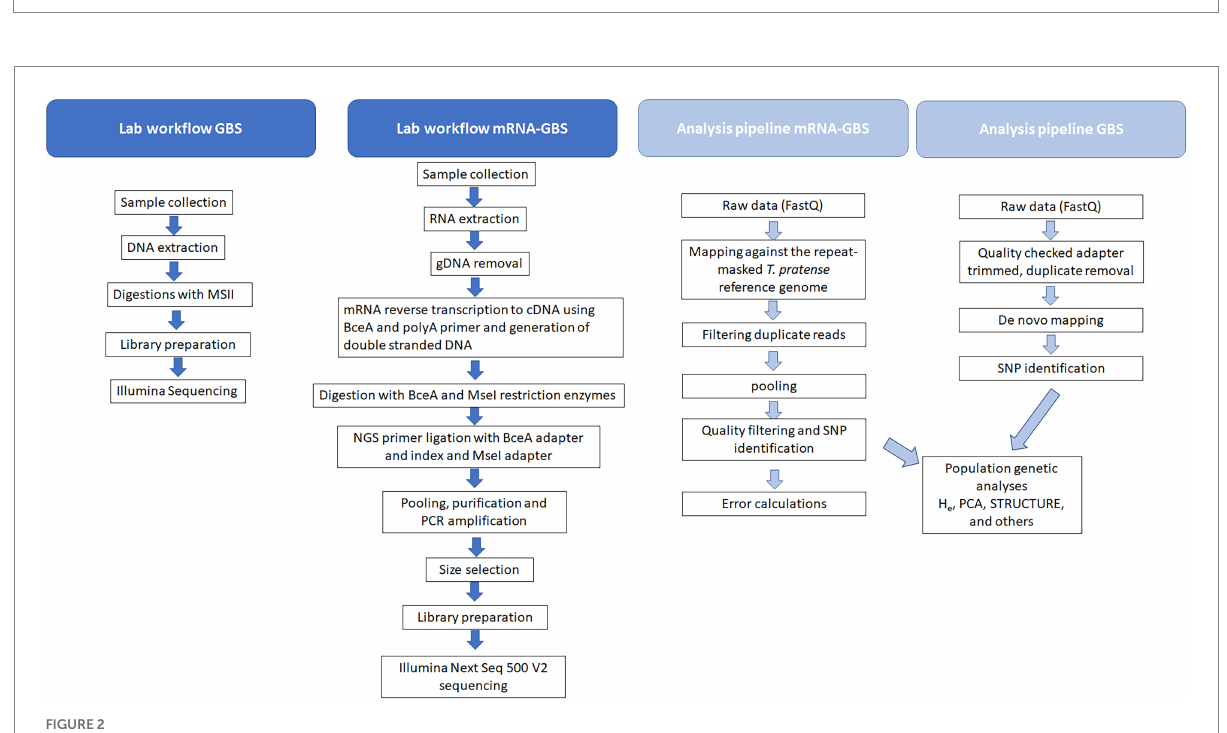
FIGURE 2 Laboratory and data analysis